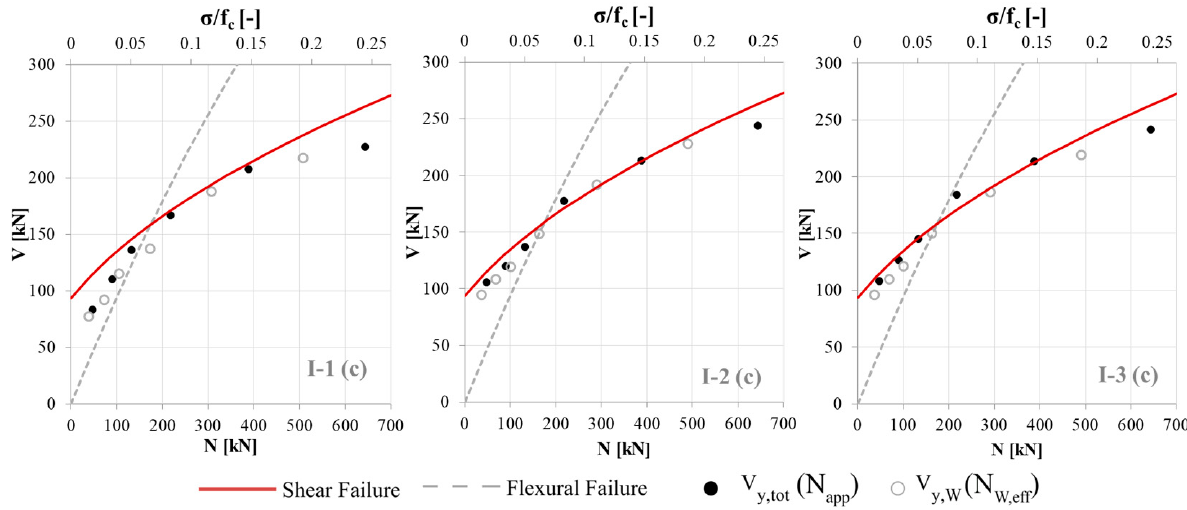
Figure 8. Failure domain of the web panel compared with the results of the numerical FE analyses for each one of the introduced case study structures (cantilever scheme); the values of V y,tot are represented in correspondence of N app , while the values of V y,W are represented in correspondence of N W,eff .